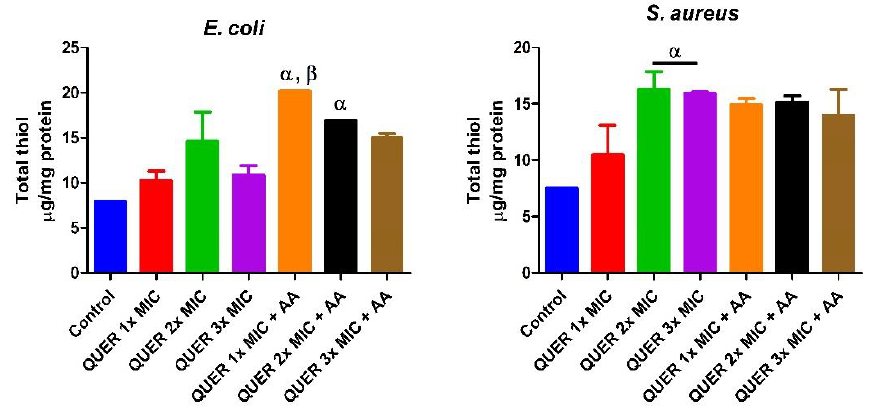
Figure 2. Concentration of total thiol in bacterial isolates following exposure to quercetin (QUER) alone or when combined with ascorbic acid (AA) . Results are presented as an average of duplicate biological experiments (n = 2) with the corresponding standard error of the mean (SEM). Compared with the control or QUER 1x MIC, α at p < 0.05 is significant, and β is significant at p < 0.01.